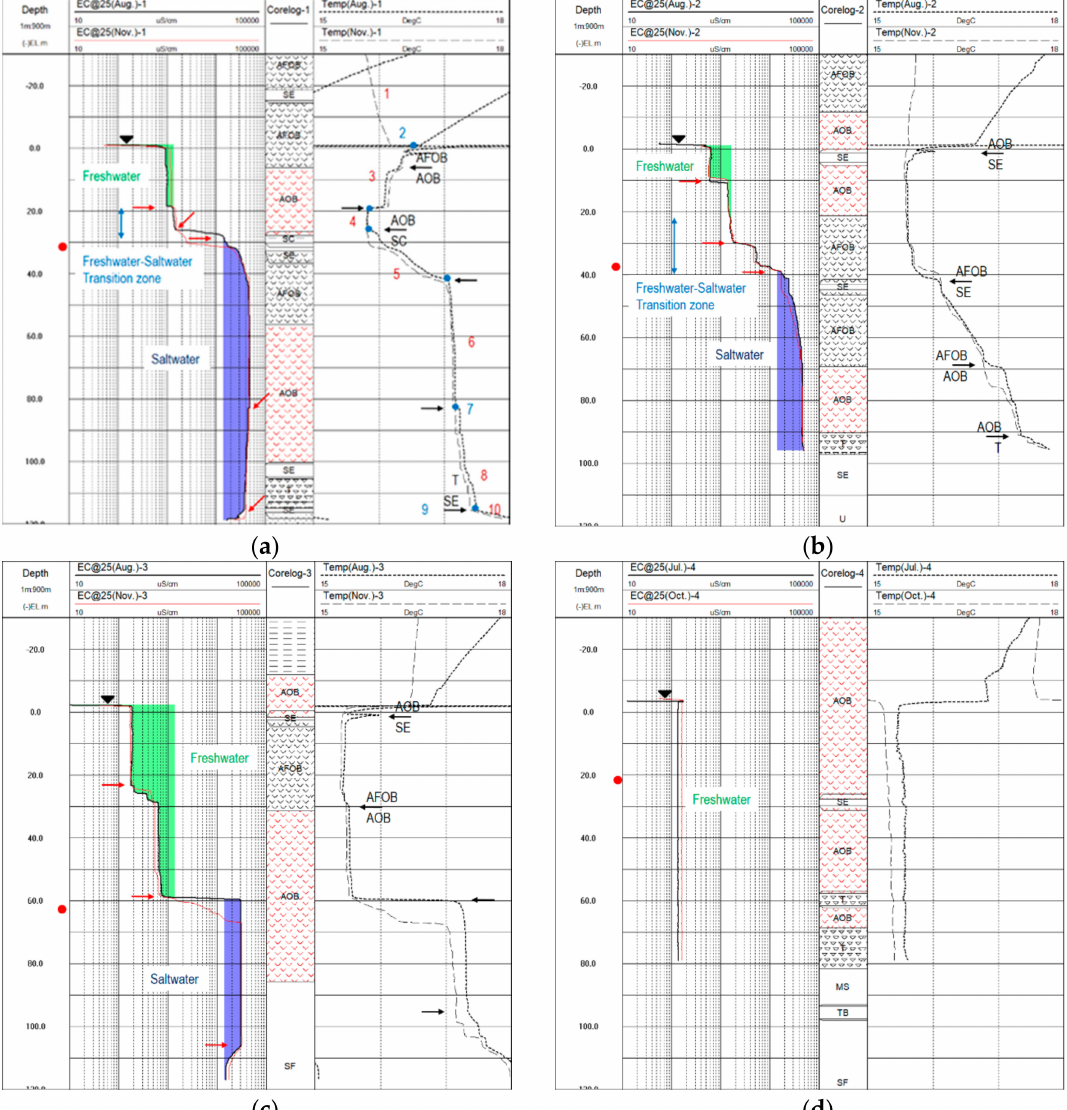
Figure 3. Profiles of electrical conductivity, geology, and temperature at boreholes for Susan district. ( a ) SS-1; ( b ) SS-2; ( c ) SS-3; and ( d ) SS-4. The red circle expresses monitoring sensor’s location in each borehole. Red and black arrows indicate the variation of electrical conductivity and temperature,